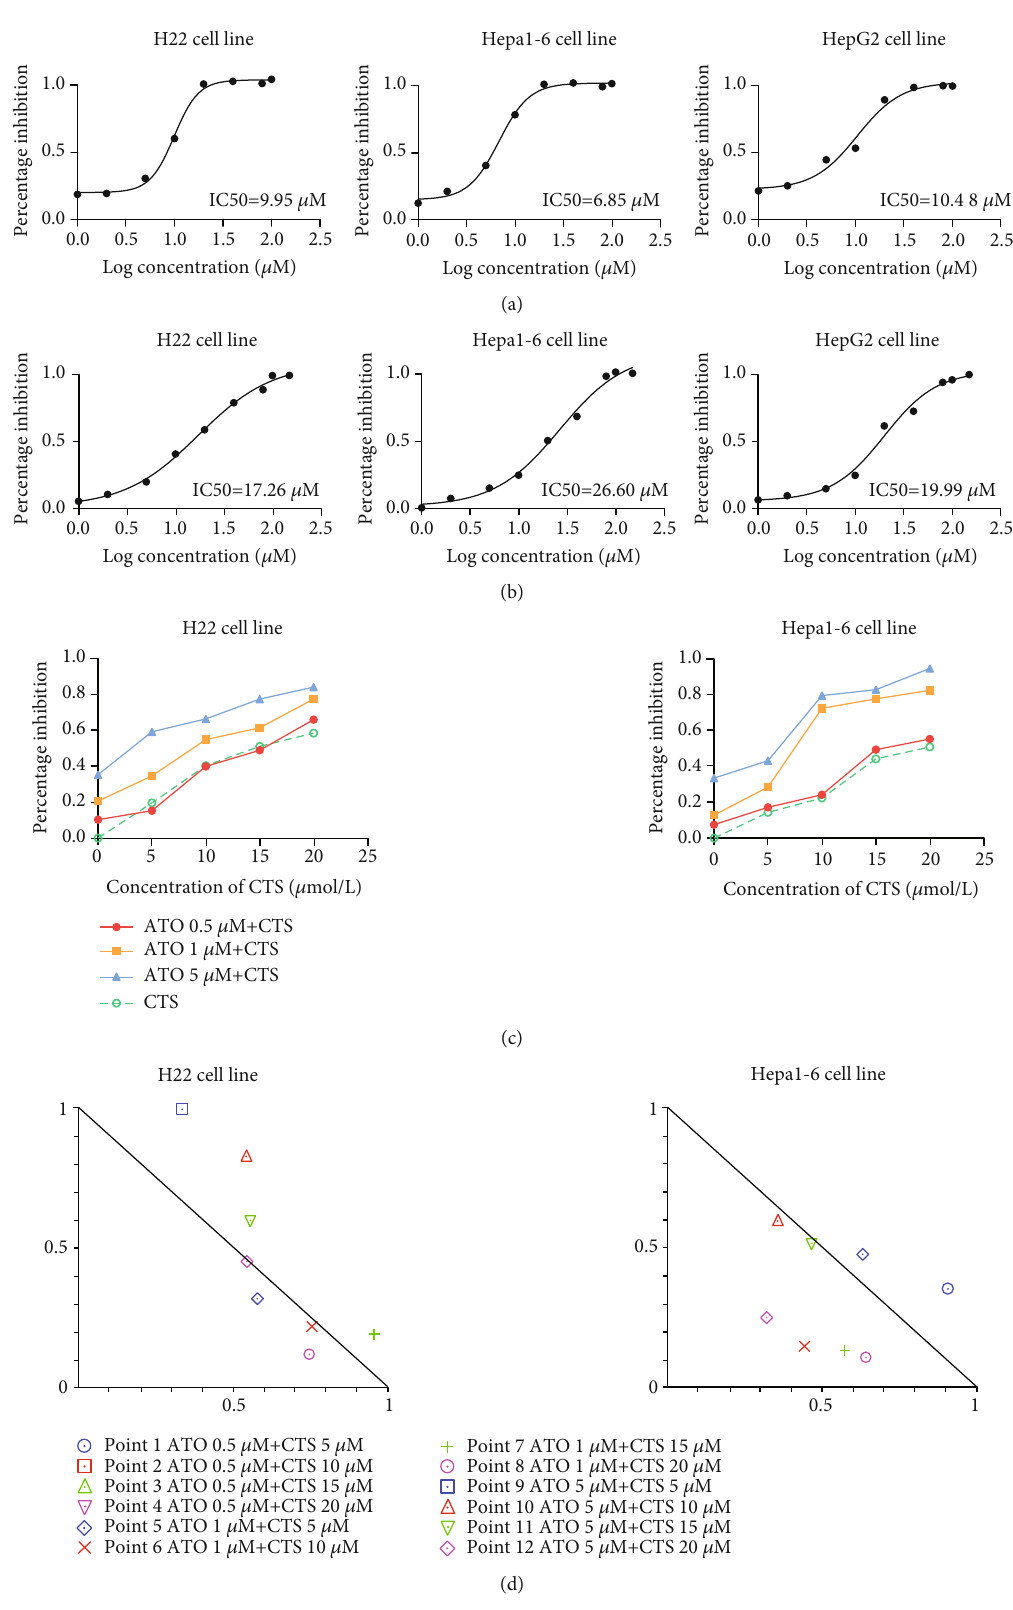
Figure 1: Inhibition curve of di ff erent HCC cells. (a) Cells treated with ATO. (b) Cells treated with CTS. (c) Cells treated with the combination of ATO and CTS (ACCS). (d) Normalized isobologram for